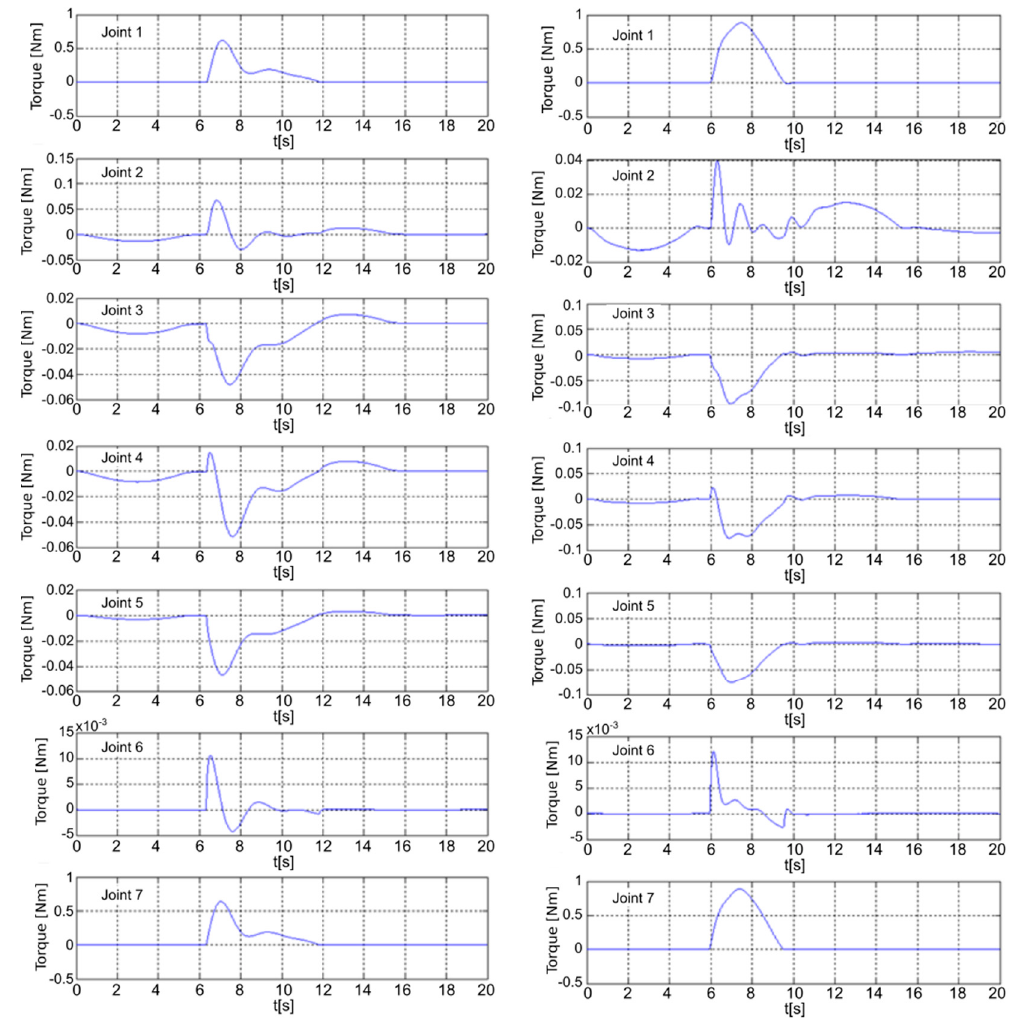
Figure 4. Comparison of time histories of the torques in robot joints. Left : model-based full robot impedance control, right : impedance control with single prismatic joint at the end effector.